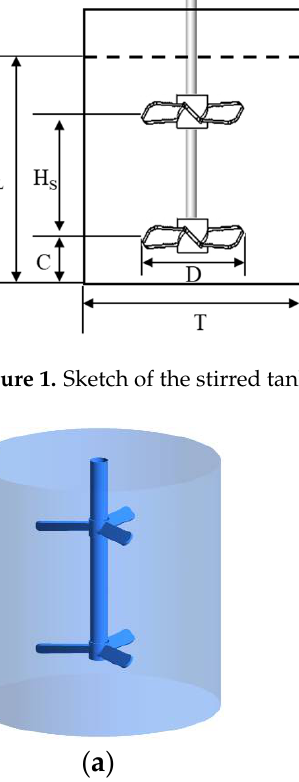
Figure 2. Structure of the impeller and the tank used in this work. ( a ) Dual triple blade impeller; ( b ) dual rigid-flexible triple blade impeller.